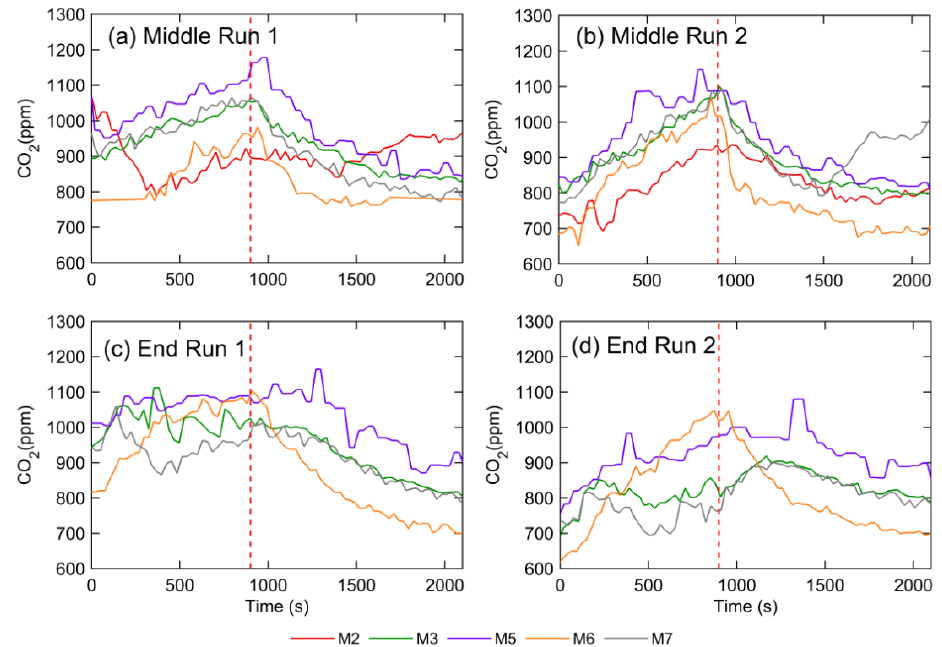
Figure 8. CO 2 concentrations for sensors placed within breathing zone for ( a ) middle run 1, ( b ) middle run 2, ( c ) end run 1 and ( d ) end run 2. Red dashed lines show time at which venti- lation is switched